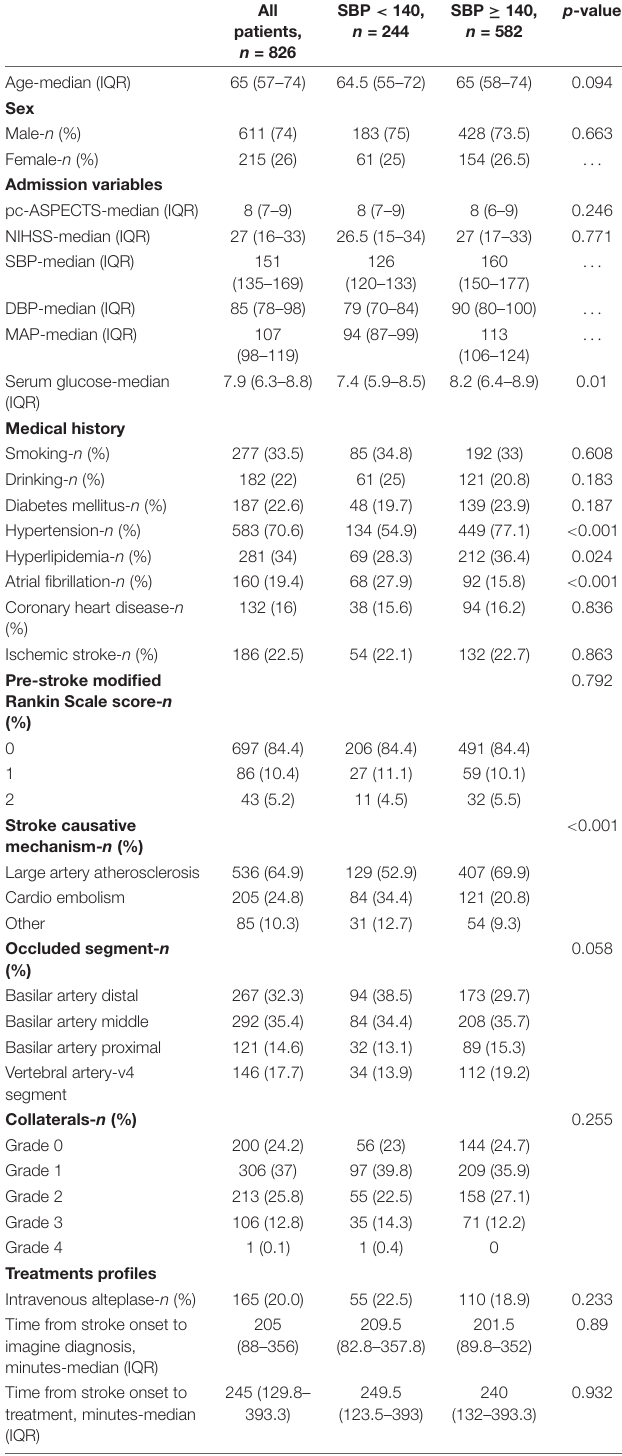
TABLE 1 | Baseline characteristics according to admission systolic blood